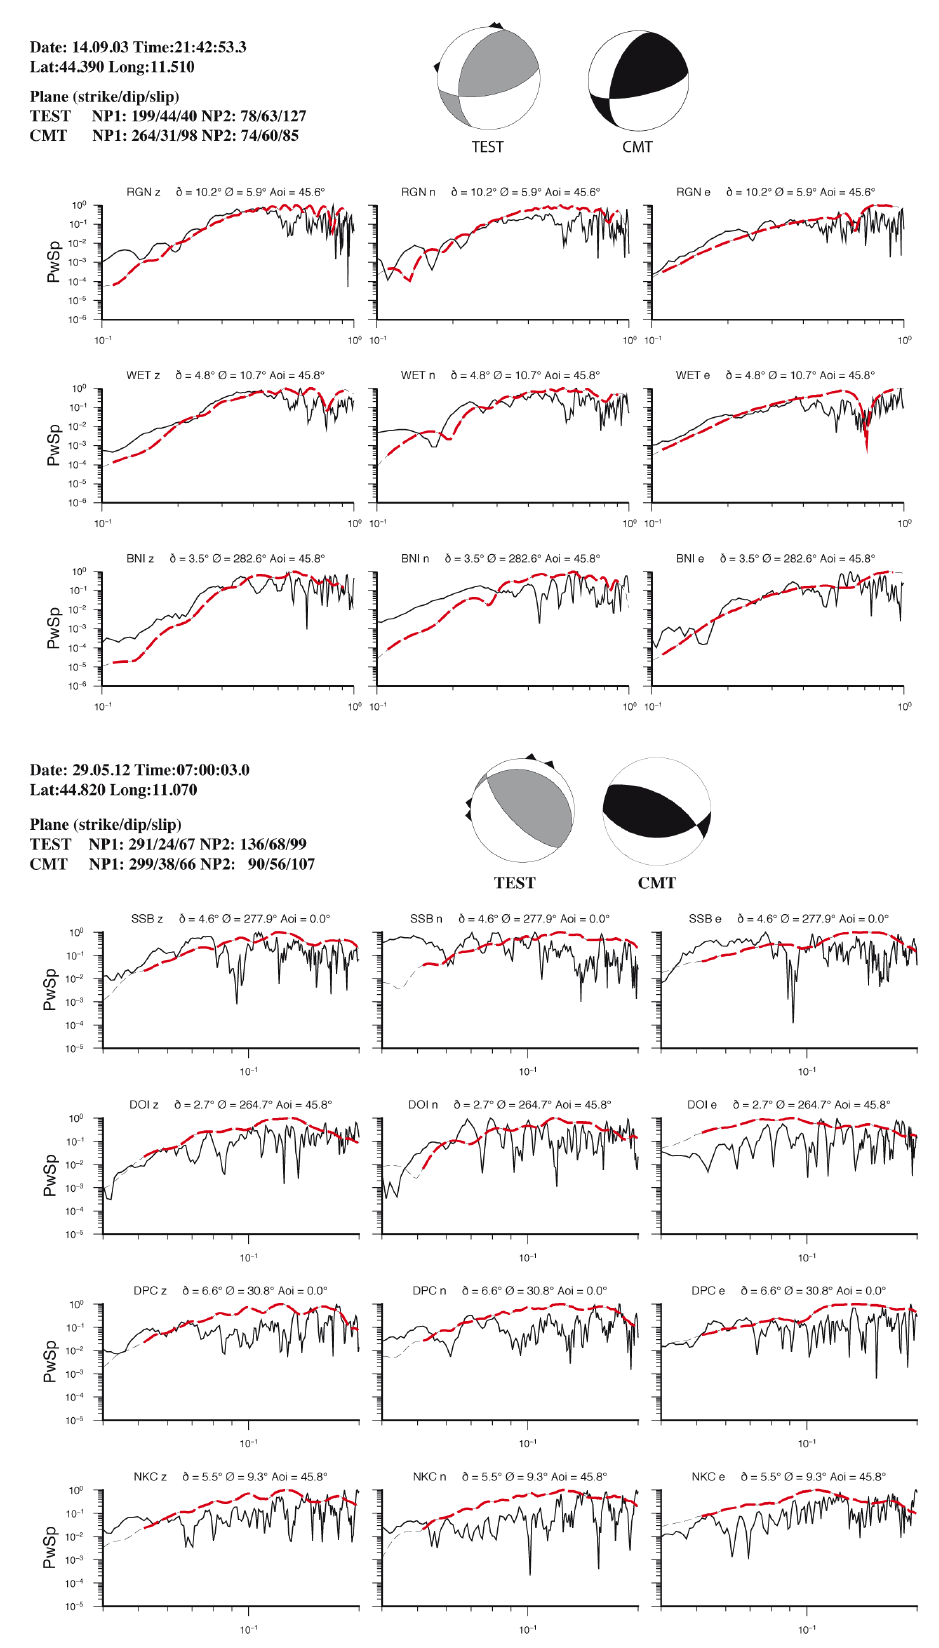
Figure 6. Examples of MT inversion solution for 2 recent earthquakes. Top: the northern Italy, September 2003 (left beachball) compared with the CMT-Harvard solution (right beachball). On the top left side are reported the origin time, the epicenter location used for the in- version and the two planes for our test and for the CMT solutions respectively. Below the spectral amplitude for the three station used. In each panel is reported the station code, seismogram directions (E-W/N-S) and synthetic (dark and dash lines) and observed (gray line) power spectra amplitude are shown. Distance ( D ) azimuth ( U -) and take off angle (Aoi) between epicenter and station are also indicated. Bot- tom: the northern Italy, May